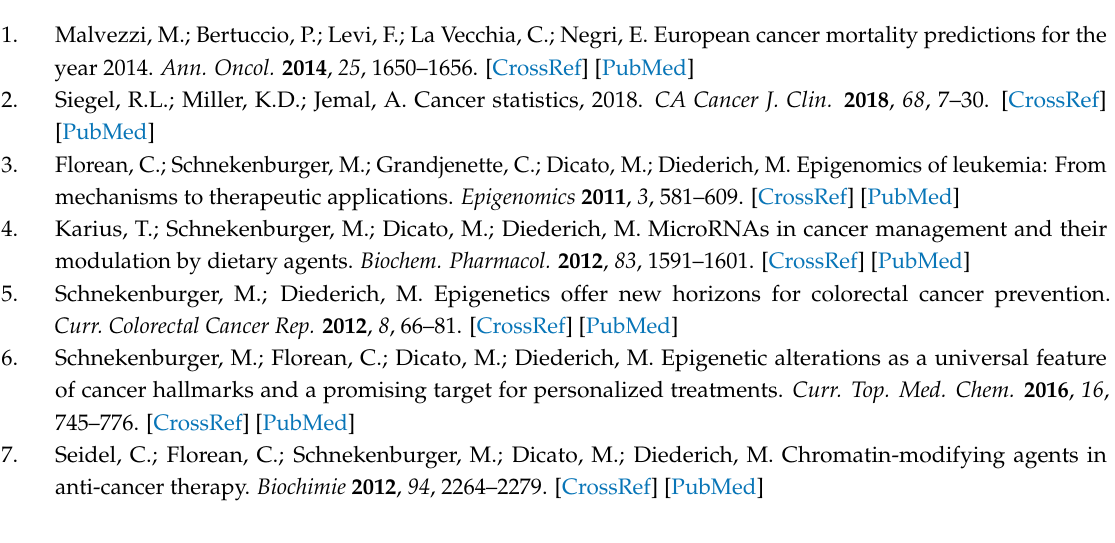
Supplementary Materials: The following are available online; Figure S1: Control docking results; Figure S2: Suramin fails to induce histone H4 or α -tubulin acetylation in K-562 cells; Table S1: Global drug-likeness parameters calculated for reference sirtuin inhibitors and